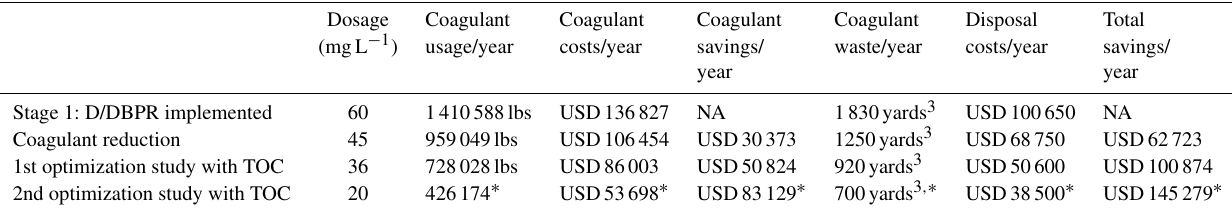
Table 2. Chemical and disposal cost savings achieved by adding in TOC analysis. Dosage Coagulant Coagulant Coagulant Coagulant Disposal Total (mgL − 1 ) usage/year costs/year savings/ waste/year costs/year savings/ year